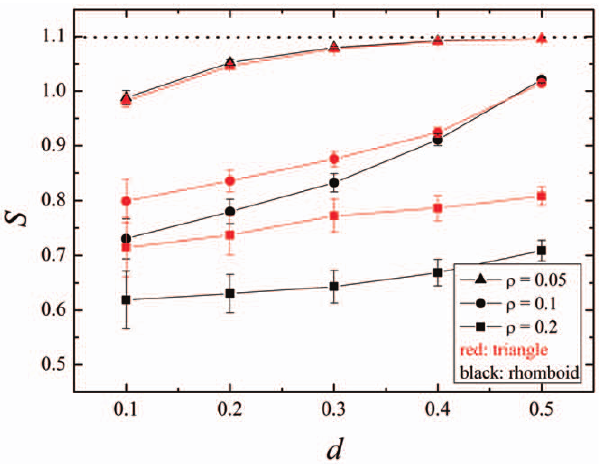
Figure 7. Entropies of the distribution of extincts, as a function of habitat destruction. Red: triangle model; black: rhomboid model. Three network densities are shown: low ( m ), middle ( . ) and high ( & ). The dashed line near the top represents the maximum entropy, corresponding to a uniform distribution.